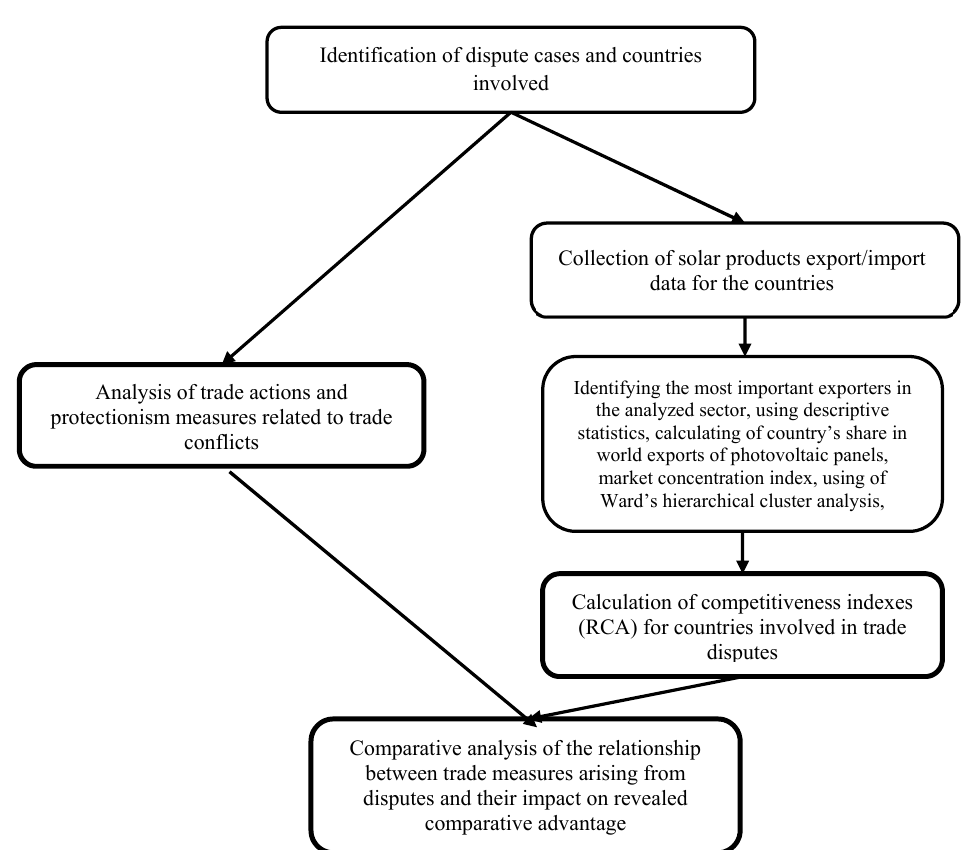
Figure 1. Research conceptualization (research strategy).